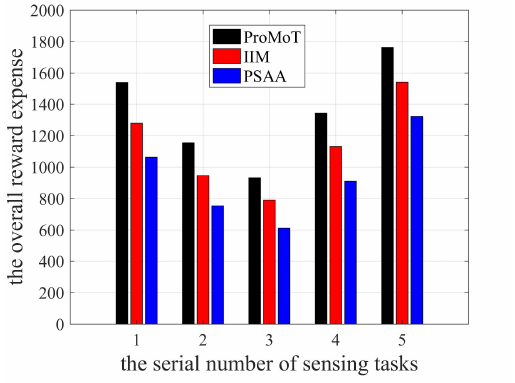
Figure 10. The overall reward